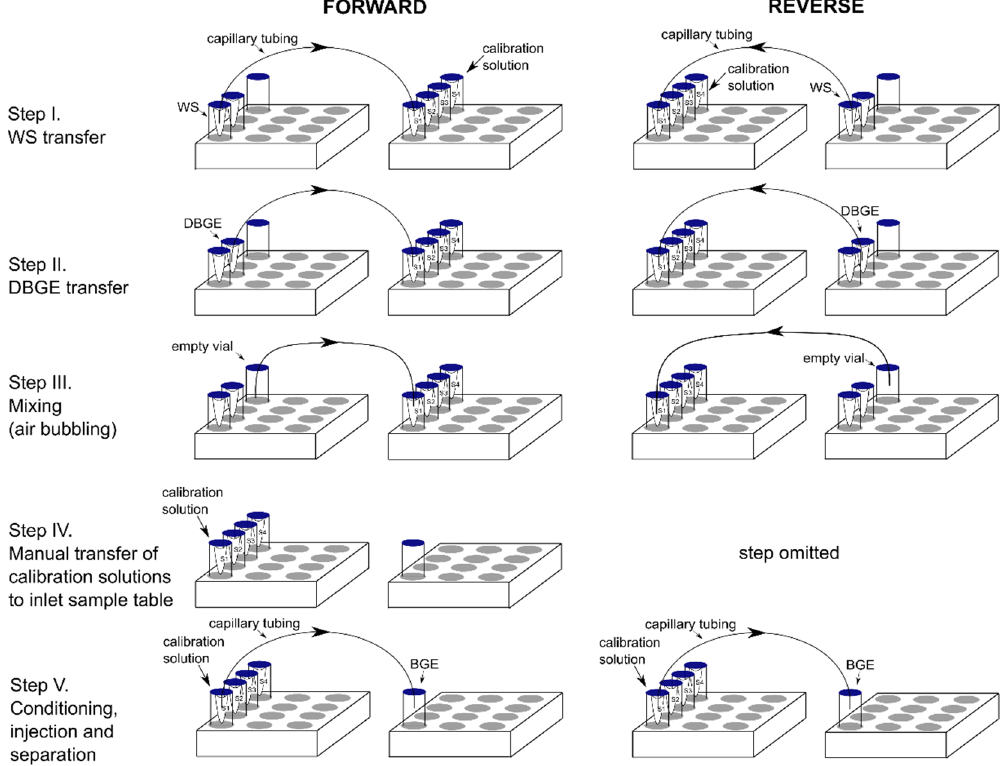
Figure 1. Scheme comparing performance of two modes of AHMT. To avoid carryover of one of the solutions, a rinsing procedure of the capillary was proposed. Initially, the capillary was rinsed (137.90 kPa, 20 psi) with water (1.5 min) and methanol (1 min), then dried with air flow (1.5 min) and filled with WS for 2 min. Next, the tip of the capillary was cleaned by immersion in a vial filled with water. Afterwards, the appropriate volume of WS was added to all the empty PCR vials placed in the sample tray, where the calibration solutions were constituted (step I, Figure 1). In the next step, the capillary was rinsed with water (3 min) and DBGE (2 min) to make a capillary filled with the second solution. Before putting the capillary to the next vial, the tip was cleaned, as described above. Once the addition of DBGE to all vials was completed (step II, Figure 1), the capillary was rinsed with water and methanol and dried with air for 1.5 min each. To avoid a concentration gradient in the collecting vials, the vial content was gently mixed by air bubbling as a result of applying pressure of 206.86 kPa (30 psi) for 1 min to the empty vial, while the other end of the capillary was immersed in a PCR vial filled with constituted calibration solution (step III, Figure 1). Finally, the separation step proceeded (see Section